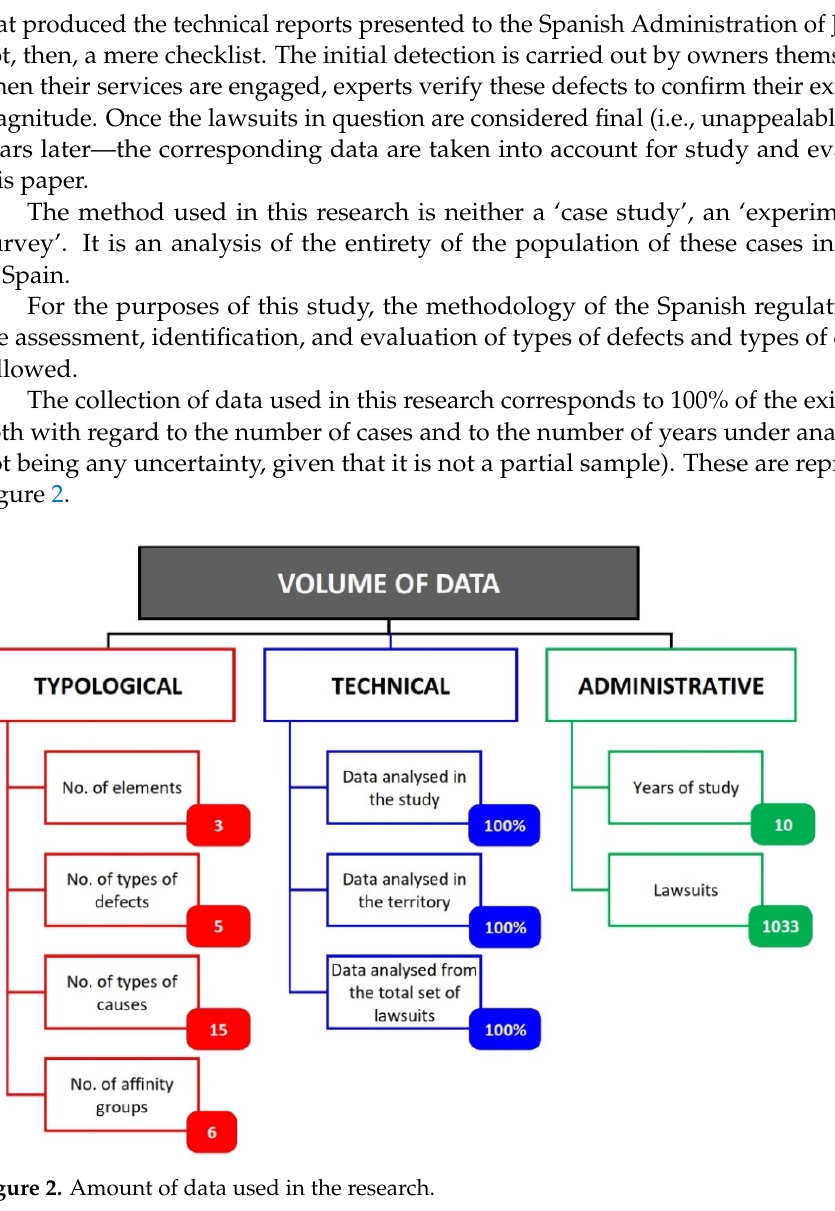
Figure 2. Amount of data used in the